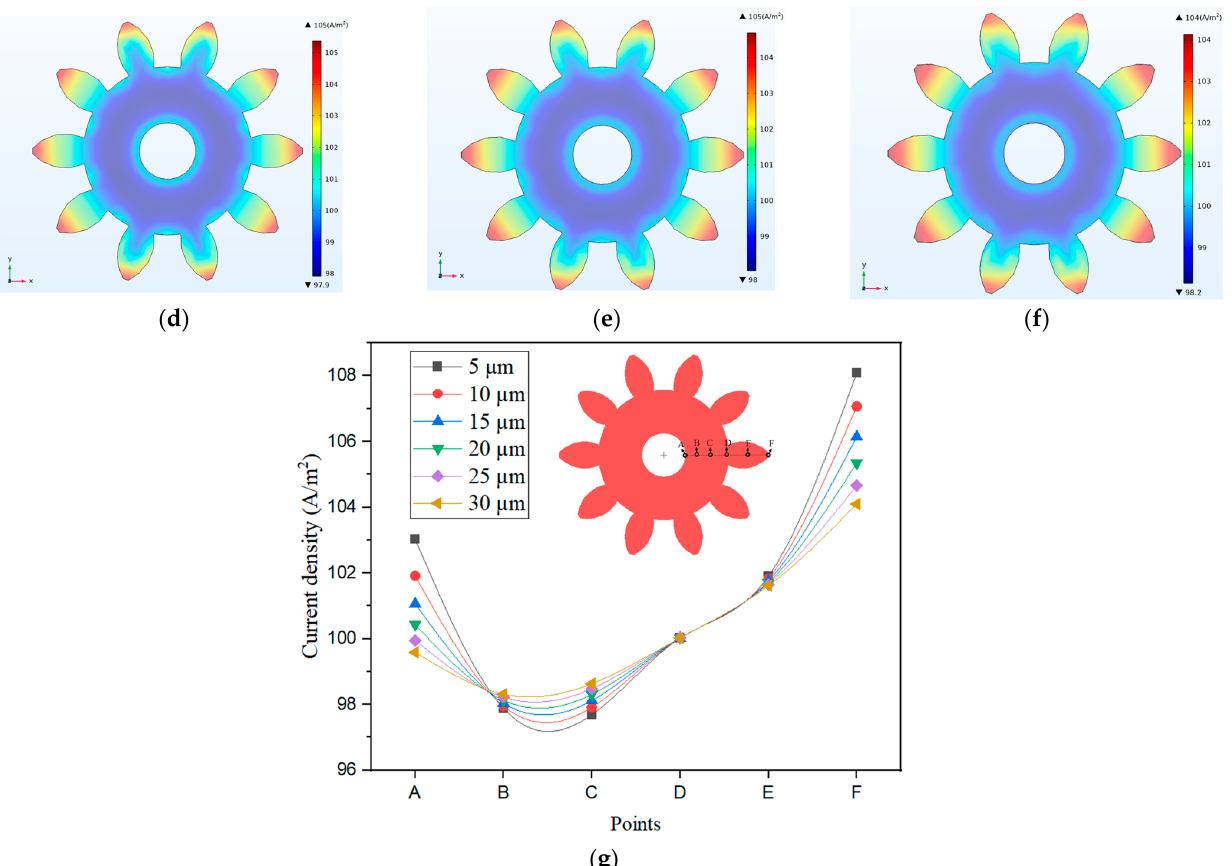
Figure 5. Simulation results of current-density distributions for different thicknesses of photoresist. ( a ) TP = 5 µm; ( b ) TP = 10 µm; ( c) TP = 15 µm; ( d ) TP = 20 µm; ( e ) TP = 25 µm; ( f ) TP = 30 µm; ( g ) current-density distribution curves of location points (A, B, C, D, E and F) for different TPs.